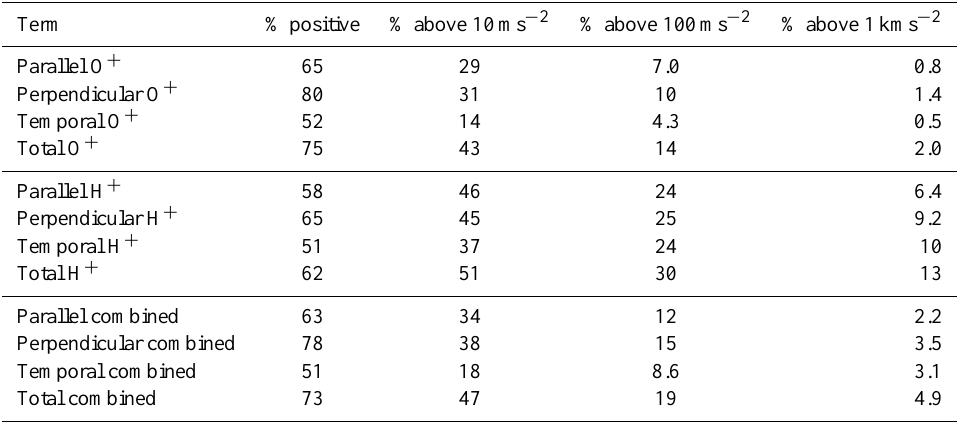
Table 1. Tabulation of the percentage of positive (outward) centrifugal acceleration above the value indicated in the header. The percentage indicated is the fraction of all data points, including negative acceleration.